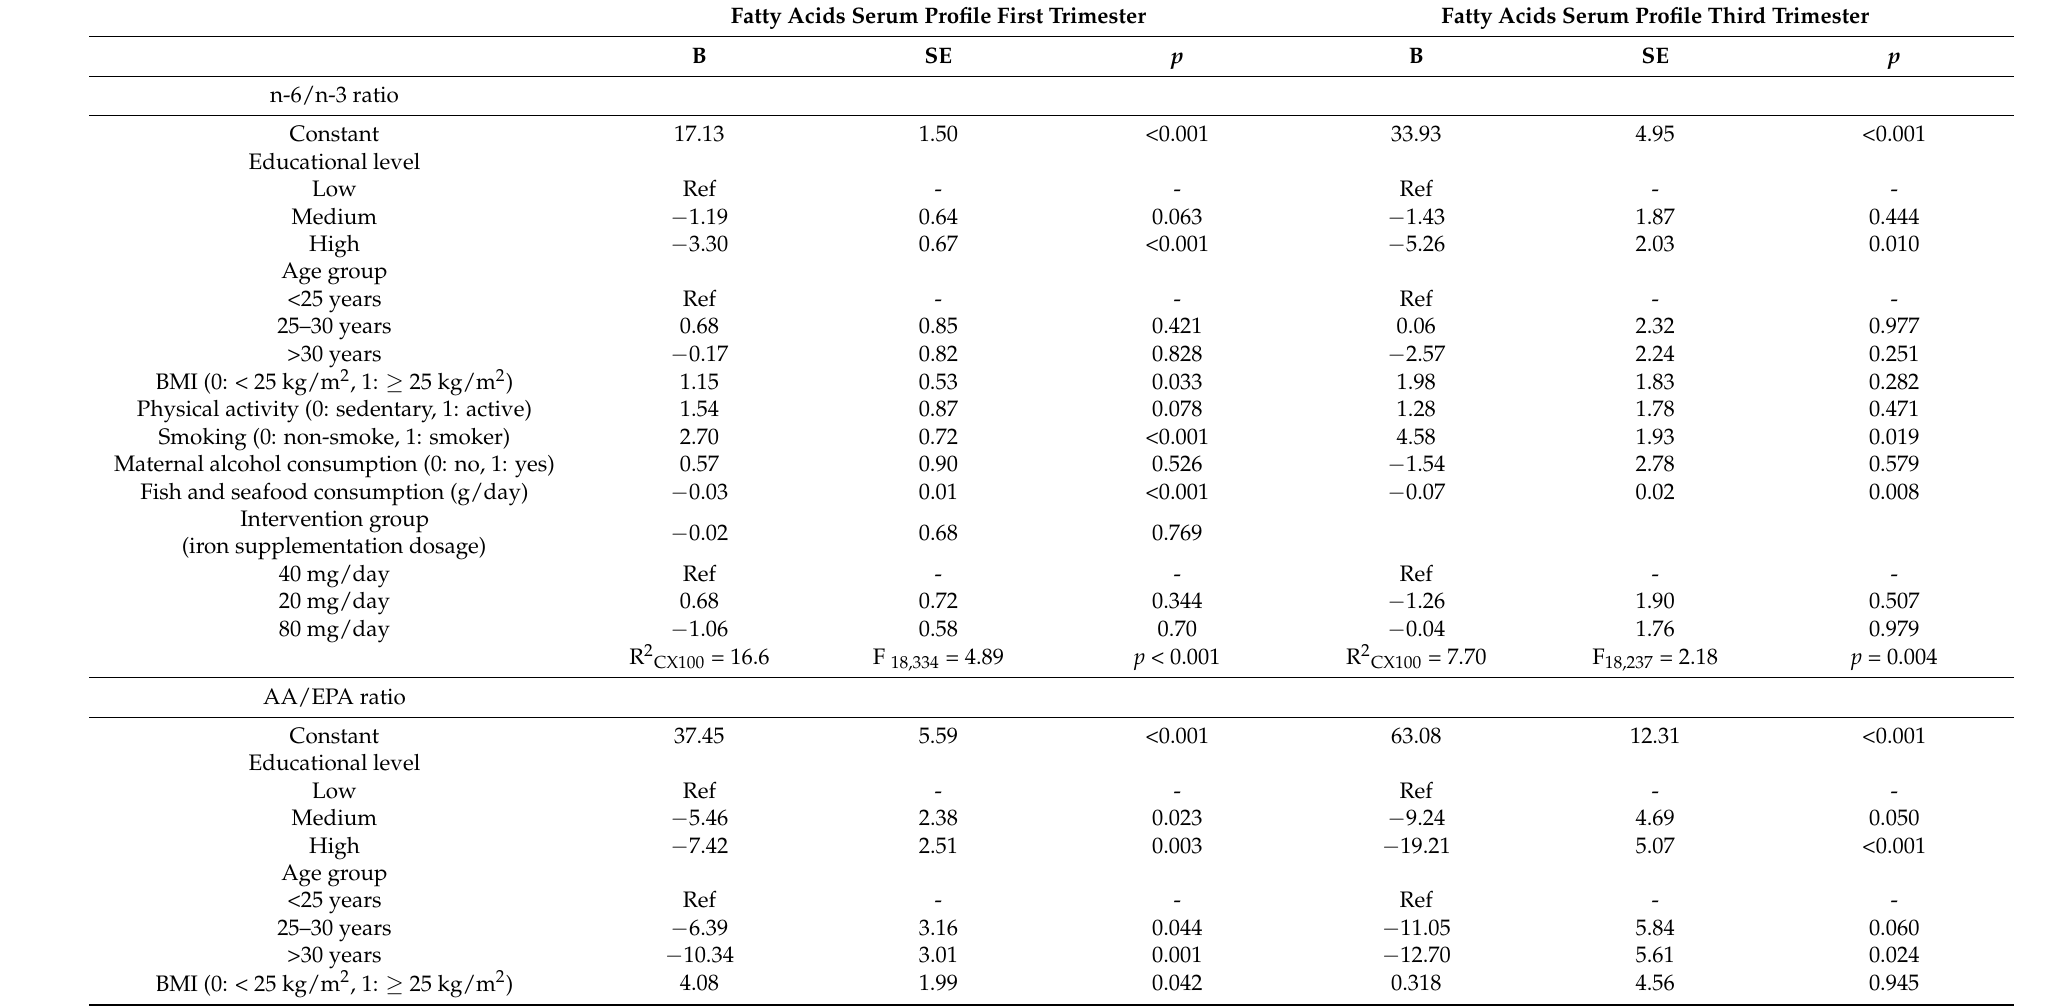
Table 4. Multiple linear regression of potential factors related to maternal serum n-6/n-3 and AA/EPA ratios. Fatty Acids Serum Profile First